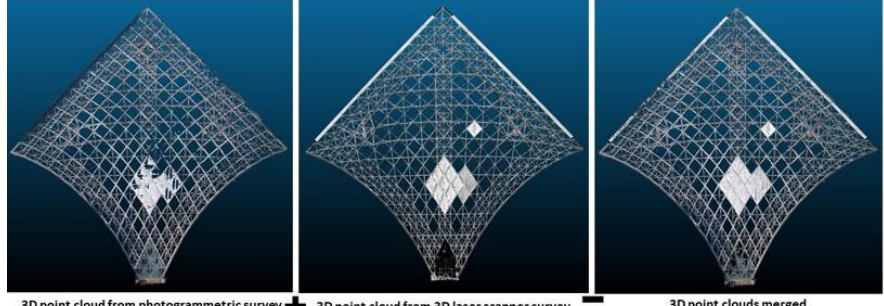
Figure 30. Comparison between the manual and AI masking times.